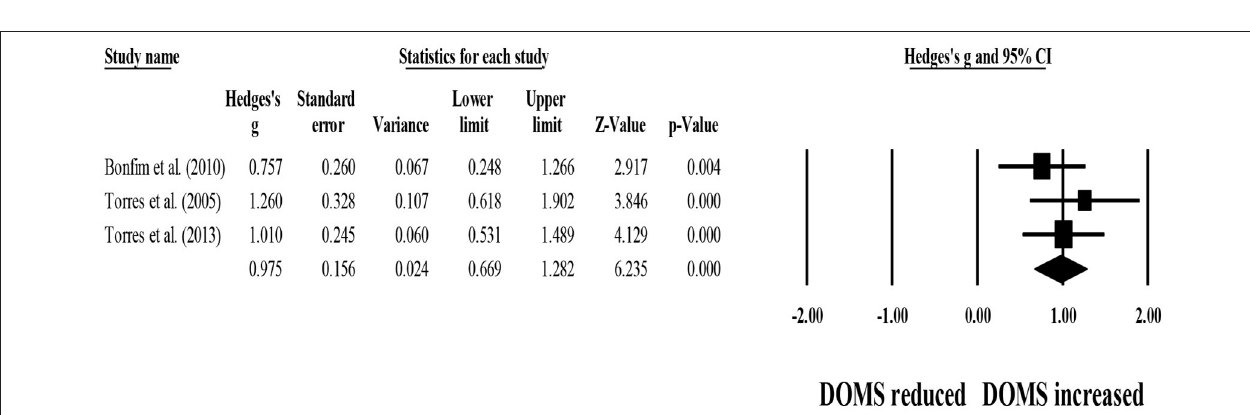
FIGURE 12 | Forest plot denoting 72-h post-exercise delayed onset of muscle soreness (DOMS) in participants that completed post-exercise stretching protocols. Values shown are effect sizes (Hedges’s g) with 95% confidence intervals (CI). The size of the plotted squares reflects the statistical weight of each study. The black diamond reflects the overall result. Note: positive values denote that post-exercise stretching protocols did not allow participants to recover their basal DOMS level (i.e., 0.00 in the